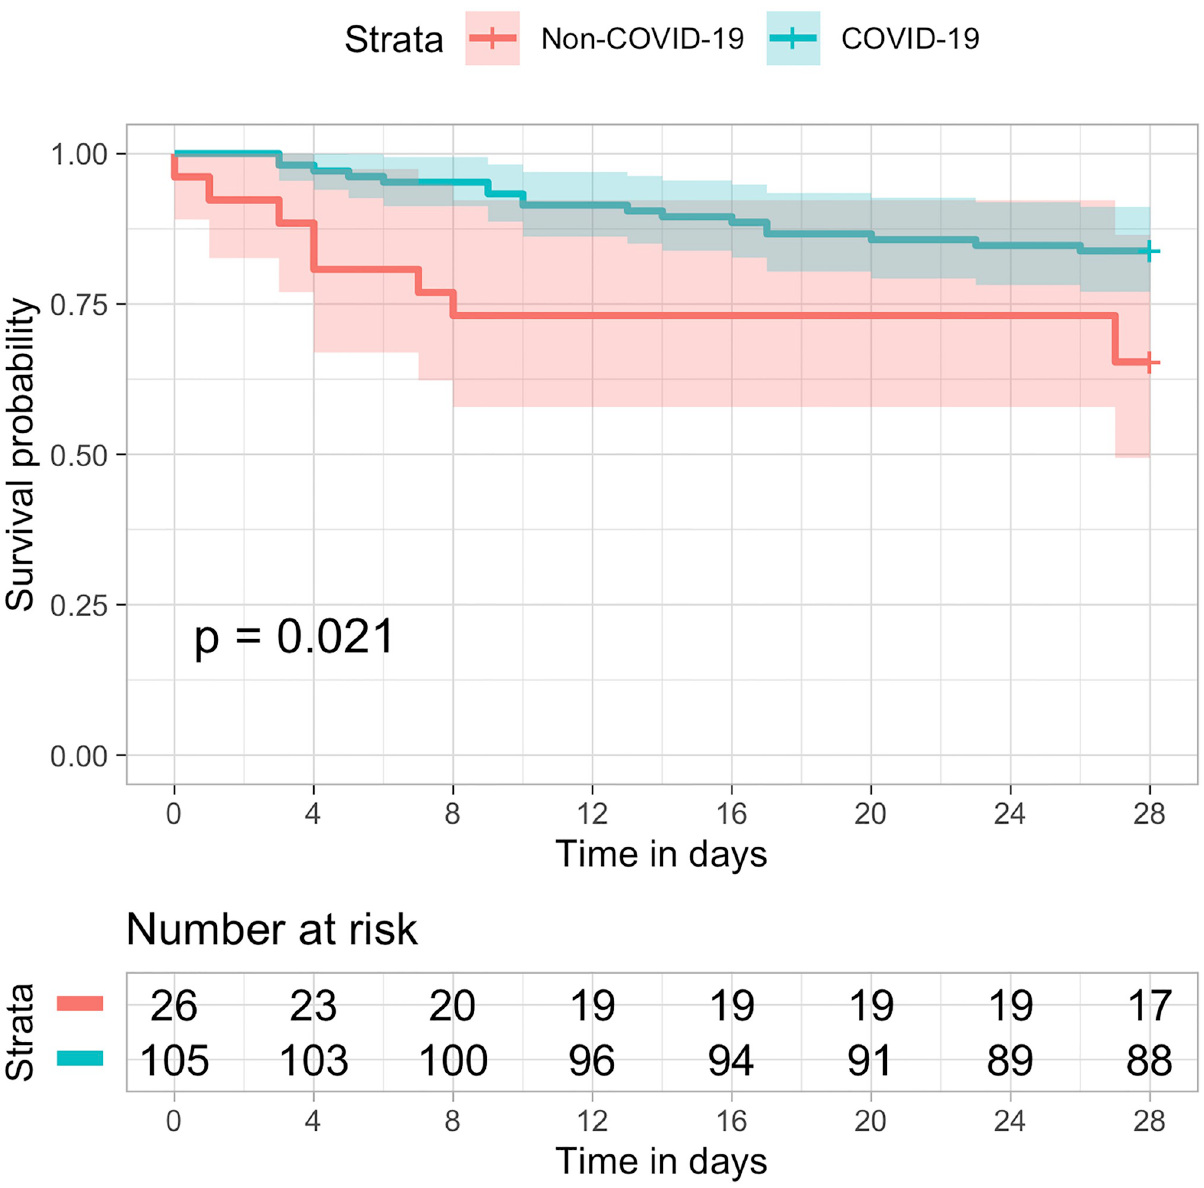
Fig 4. Kaplan–Meier estimates of all-cause survival rate up to 28 days in ventilated patients. Overall survival was longer in COVID-19 (blue) as compared to non-COVID patients (orange) in the previous year (logrank p =